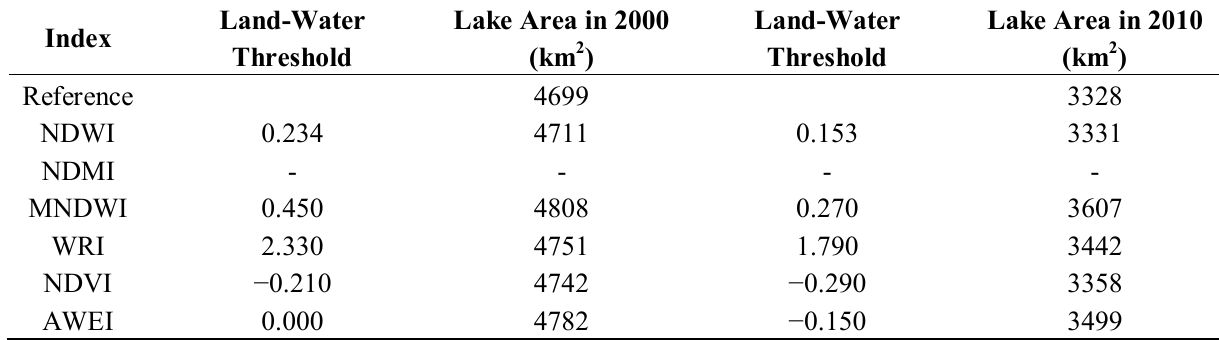
Table 3. Performance evaluation of the satellite-derived indexes used for surface water extraction.